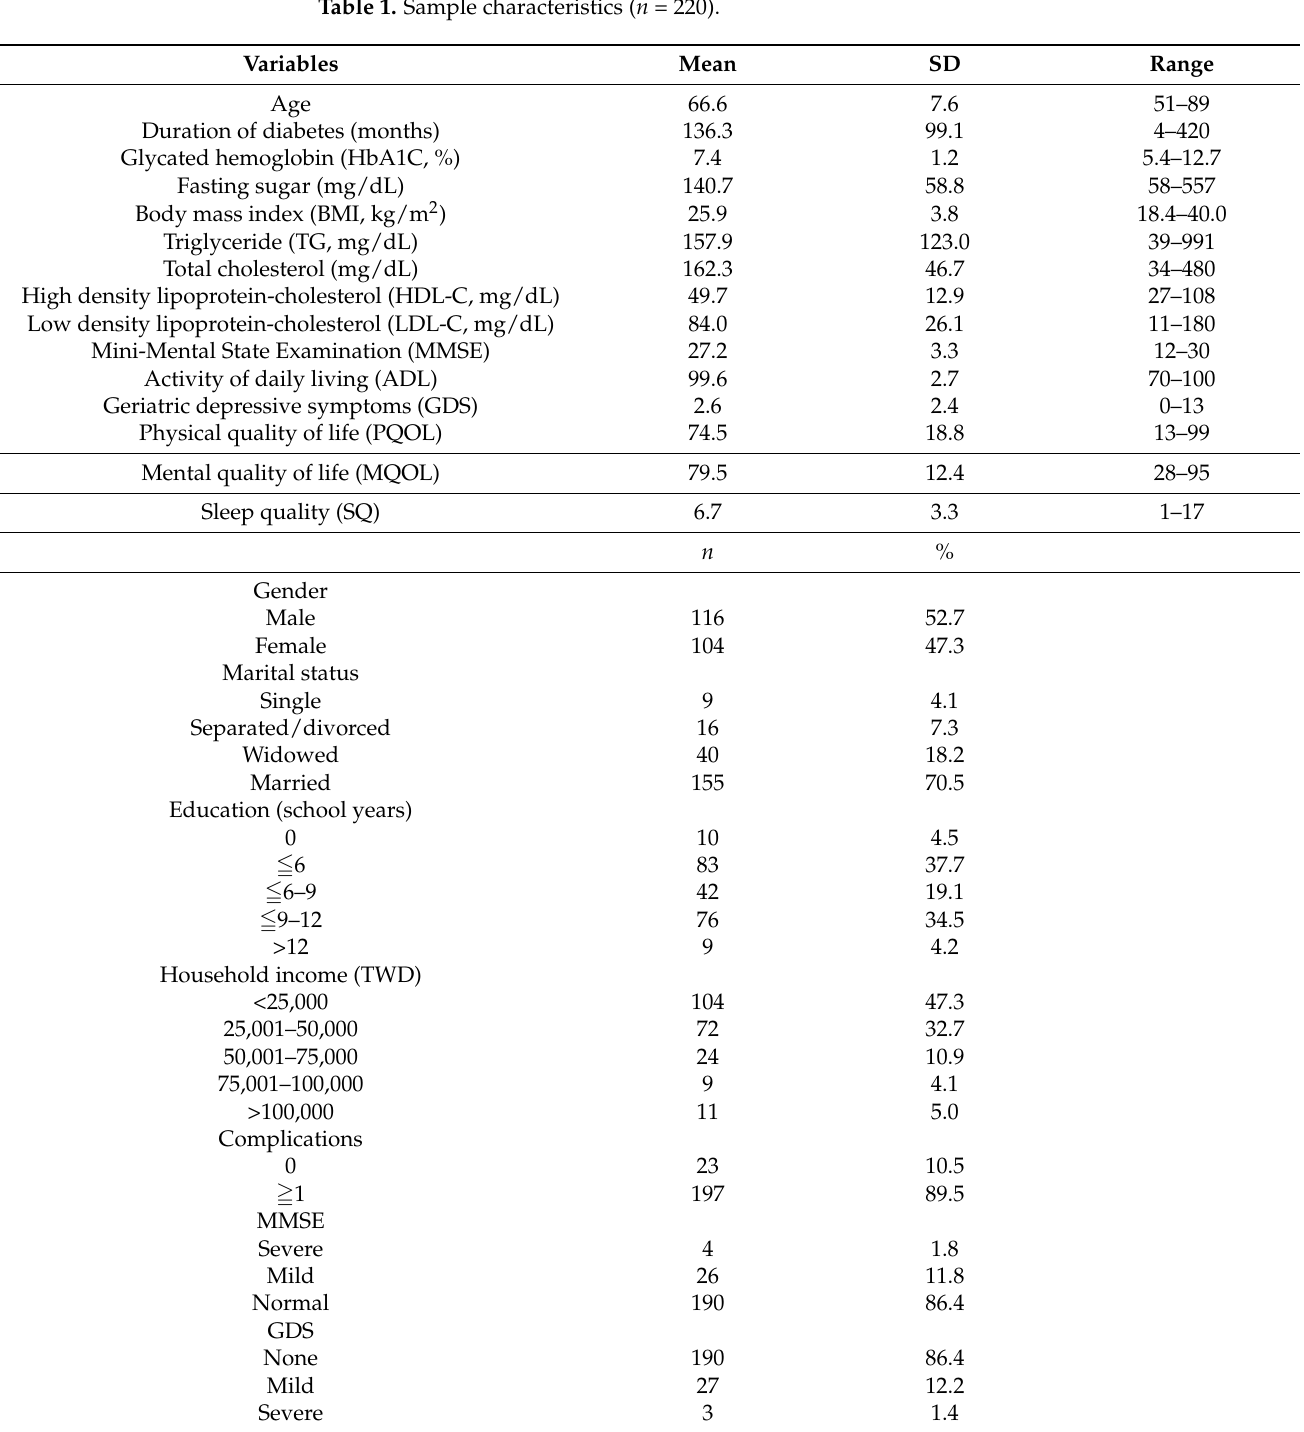
Table 1. Sample characteristics ( n =